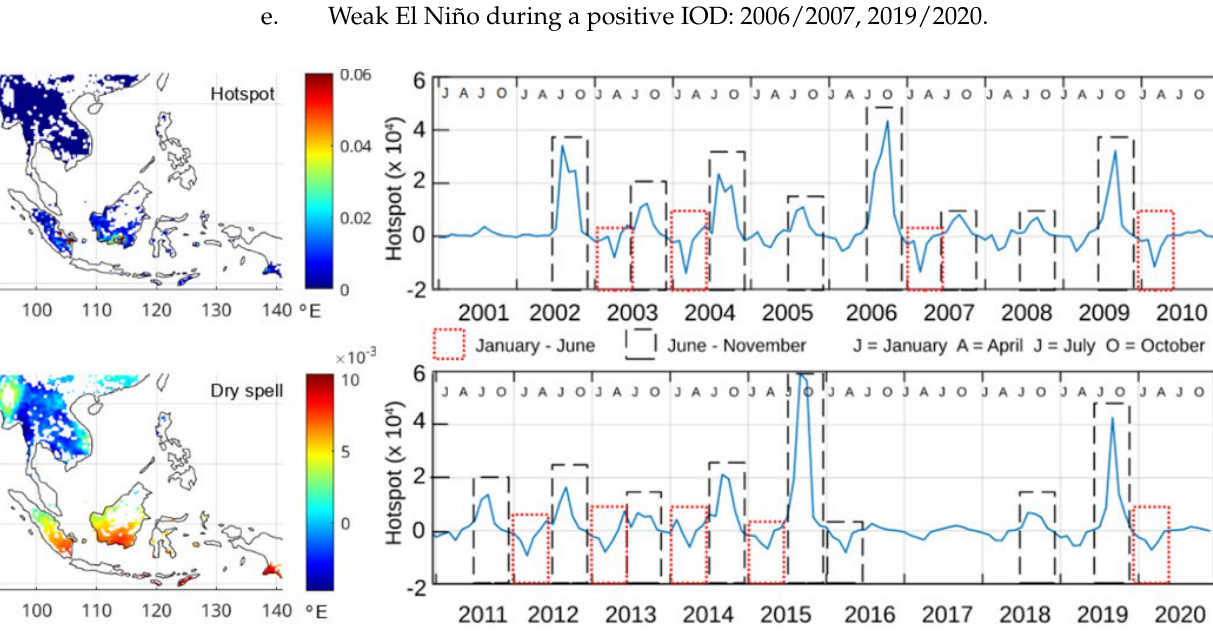
Figure 2. Southeast Asia analysis—second spatial pattern of the hotspot ( top ) and dry spell ( bottom ), as well as temporal pattern of a hotspot, 11.7% of SCF value.